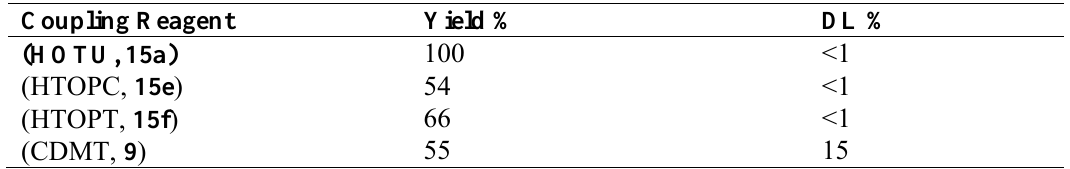
Table 1. Yield (%) and Racemization (%) of Z -Phe-Ala-OMe ( 16a ) using the Uronium Salts 15a,e,f and CDMT ( 9